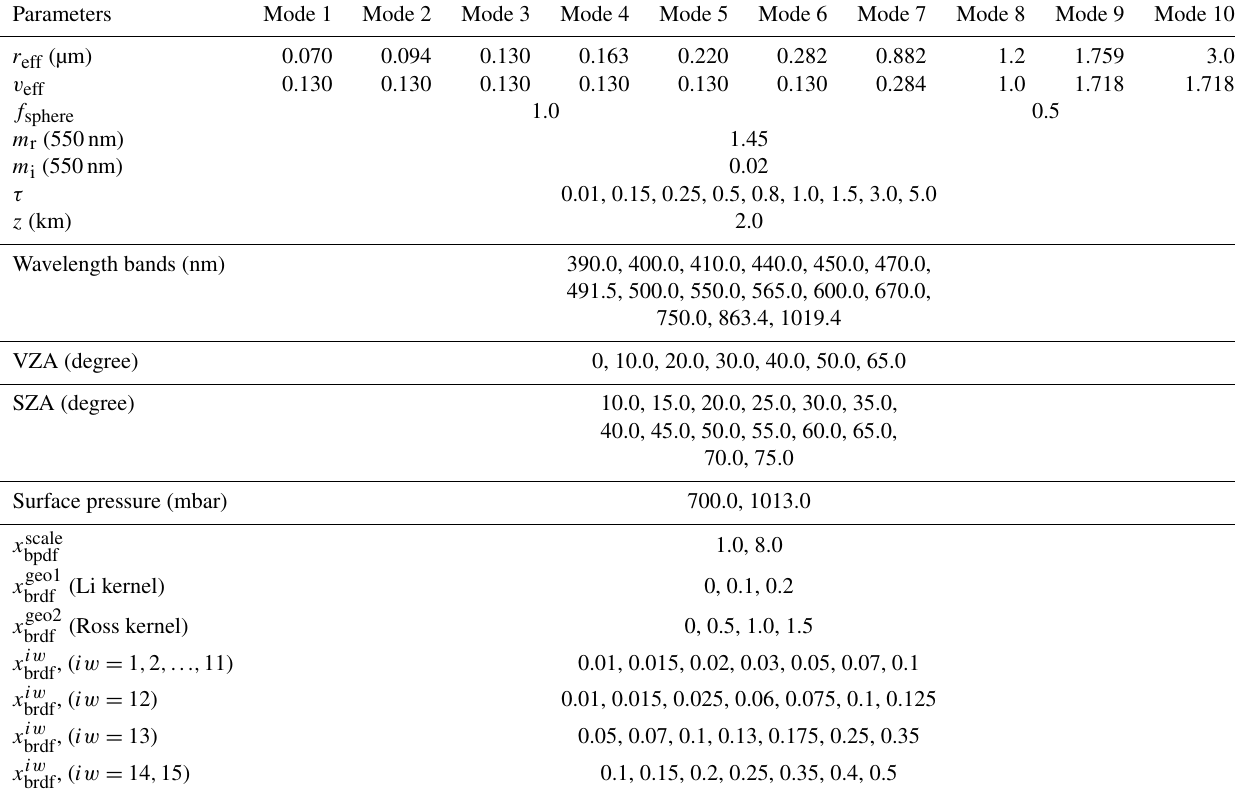
Table 6. Parameters to create a 10-mode lookup